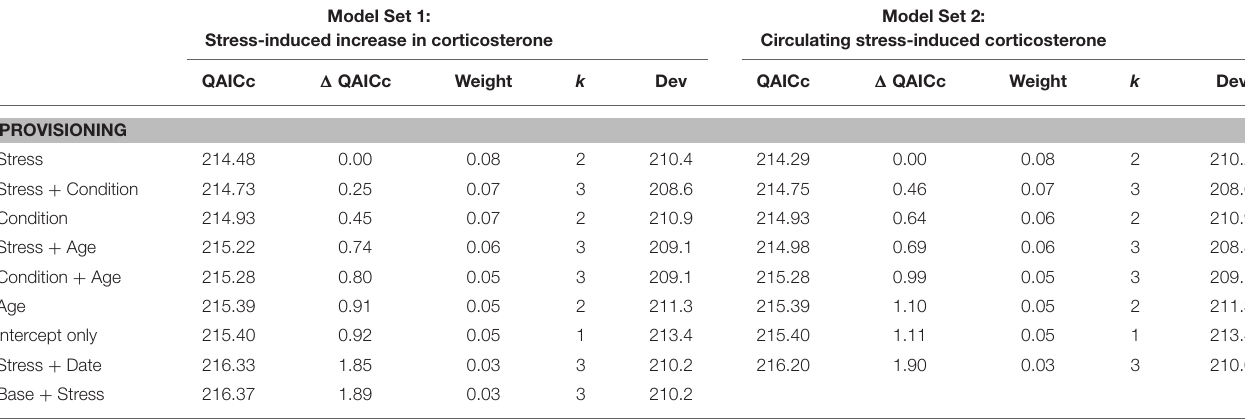
TABLE 4 | Model comparisons of annual survival probability in female tree swallows, based on data collected during the nestling provisioning period. Model Set 1: Stress-induced increase in corticosterone